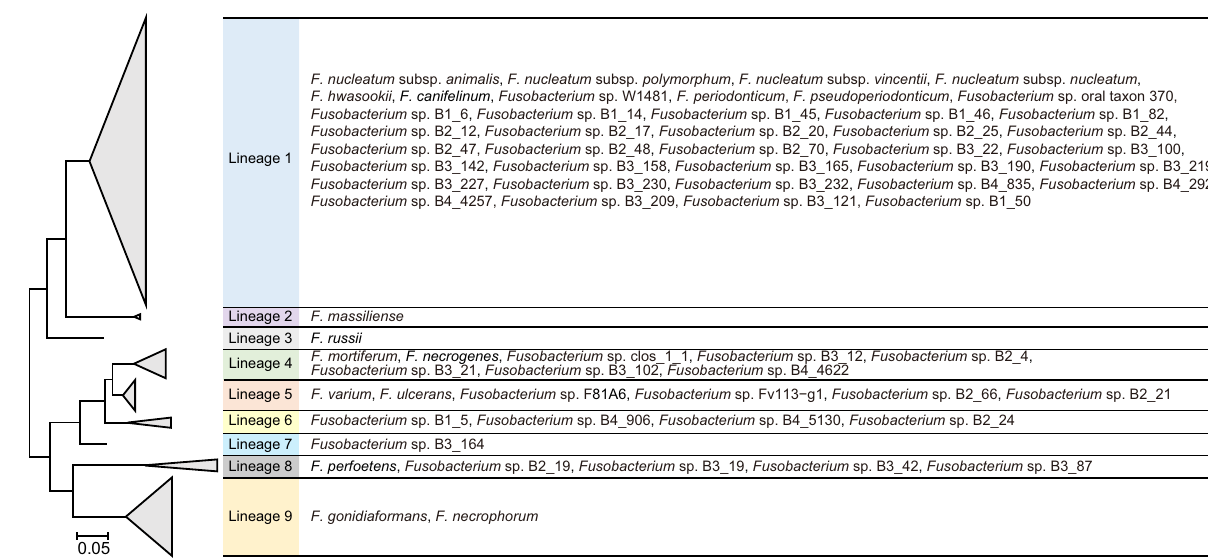
Fig. 3 Fusobacterium had diverse species members and could be divided into nine phylogenetic lineages. Newly identi fi ed and previously known species (except F. naviforme ) were included. The tree was based on the corresponding sequences in the genomes or obtained via FrpoB-seq. Branches of the same lineages are compressed with lineage names shaded in different colours, and the names of species belonging to those lineages are listed accordingly. See also Fig. S5 for the full